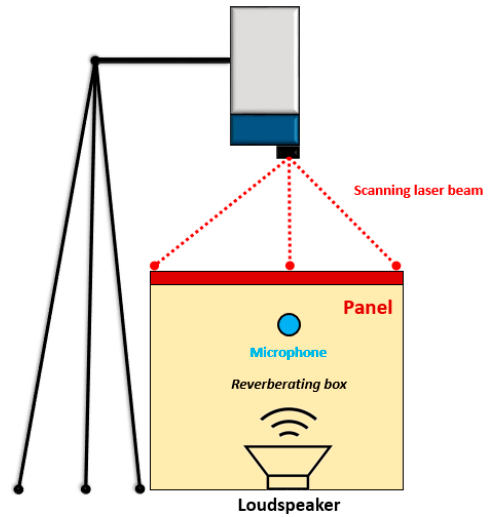
Figure 5. Laser vibrometry test set-up.